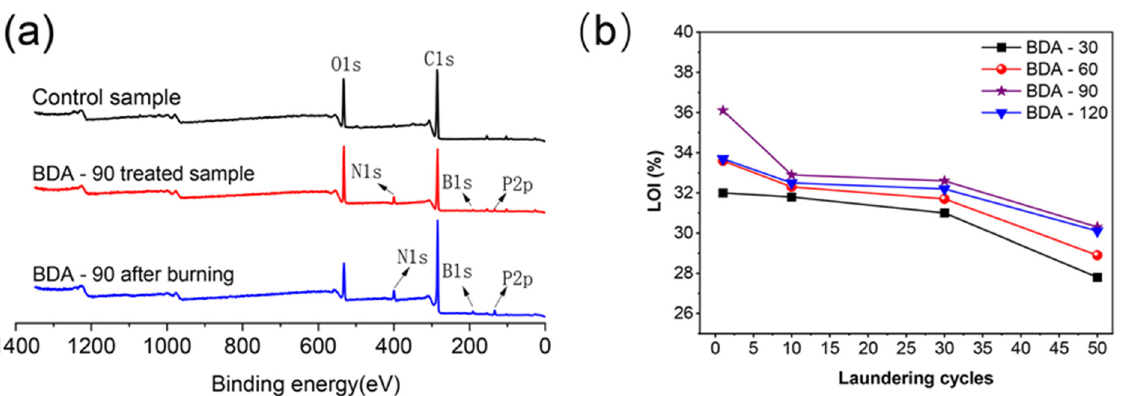
Figure 4. ( a ) XPS spectra of the control sample, BDA-90-treated sample (3 curing times, 50 LCs) before and after combustion; ( b ) LOI values of BDA treated samples (3 curing times) after 1–50 laundering cycles. Table 1. XPS elemental analyses of the control sample, BDA-90 (3 curing times, 50 LCs) before and after